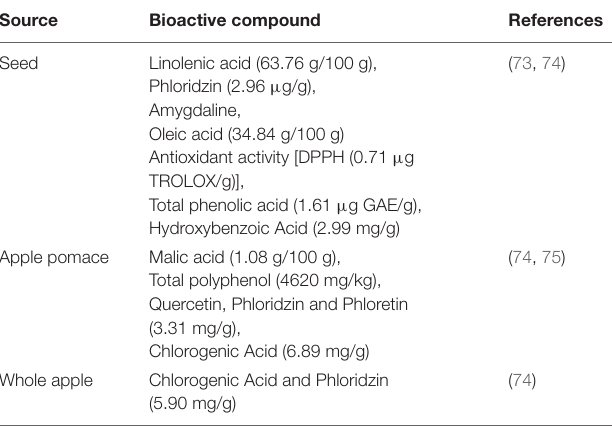
TABLE 2 | Different bioactive compounds reported in seed and pulp of